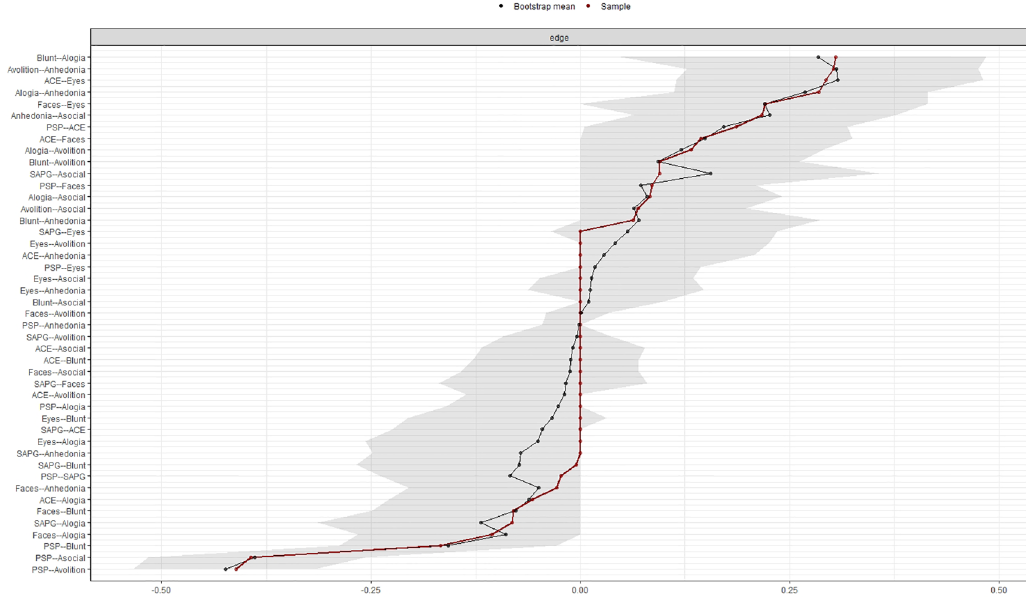
Figure 4. Accuracy of the edge weight